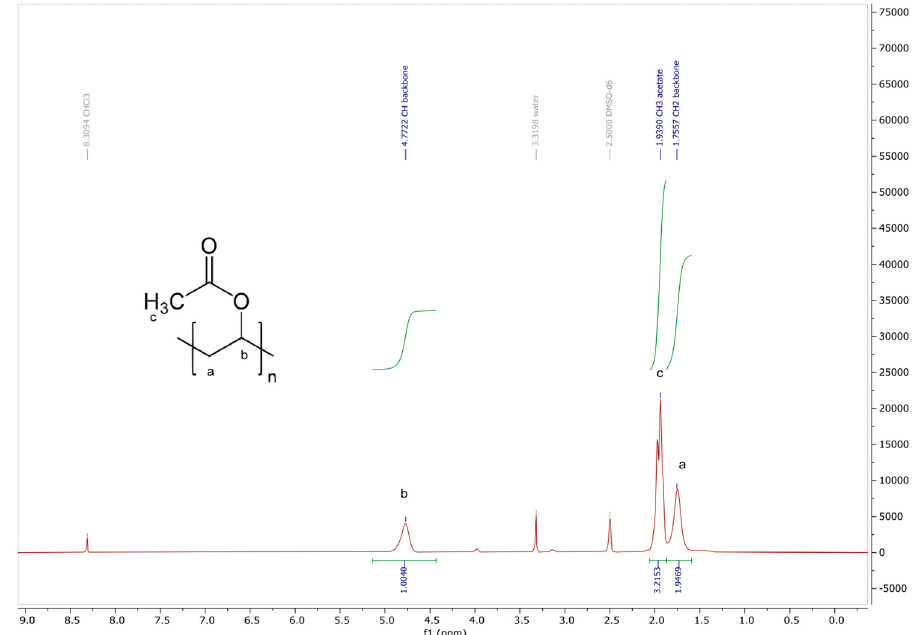
Figure 1. NMR spectrum of the synthesized PVAc.